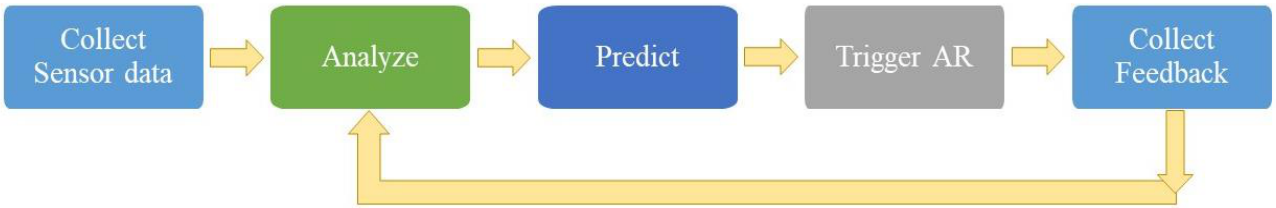
Figure 7. Application Process.